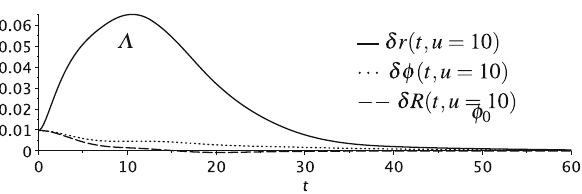
Fig. 8 Time dependence of the perturbations to the solution presented in Fig.6 (values at u = 10)